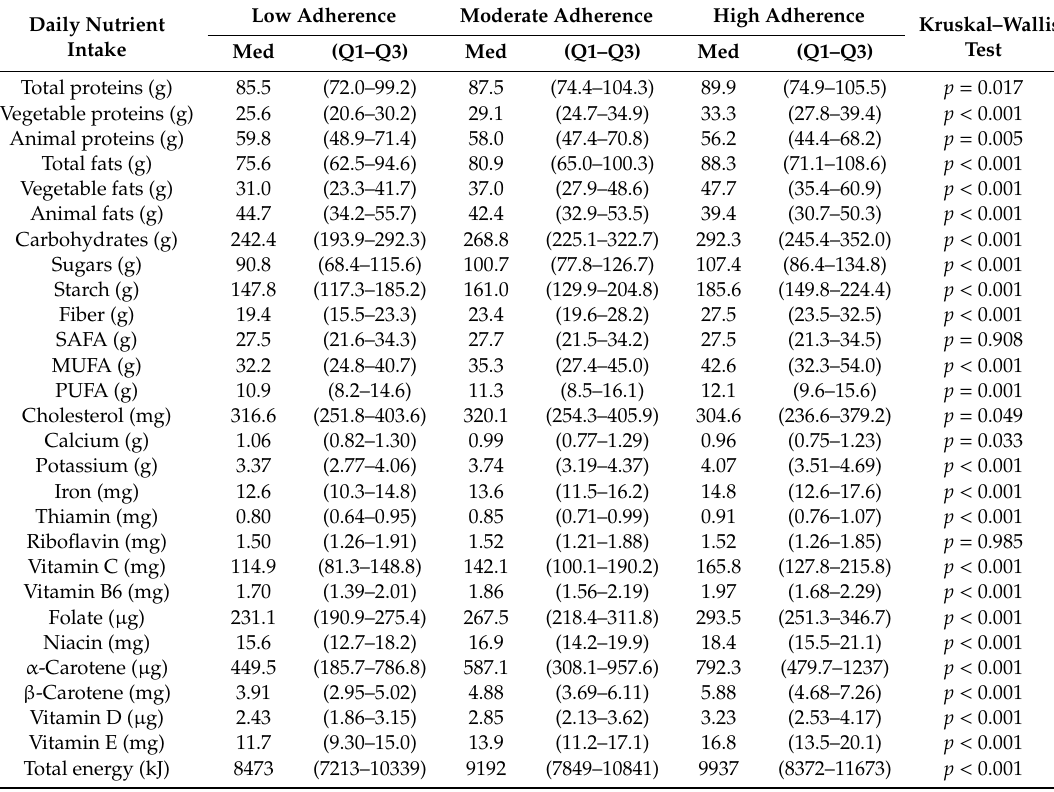
Table 3. Nutrient median values and interquartile range (Q1–Q3) according to adherence to Mediterranean